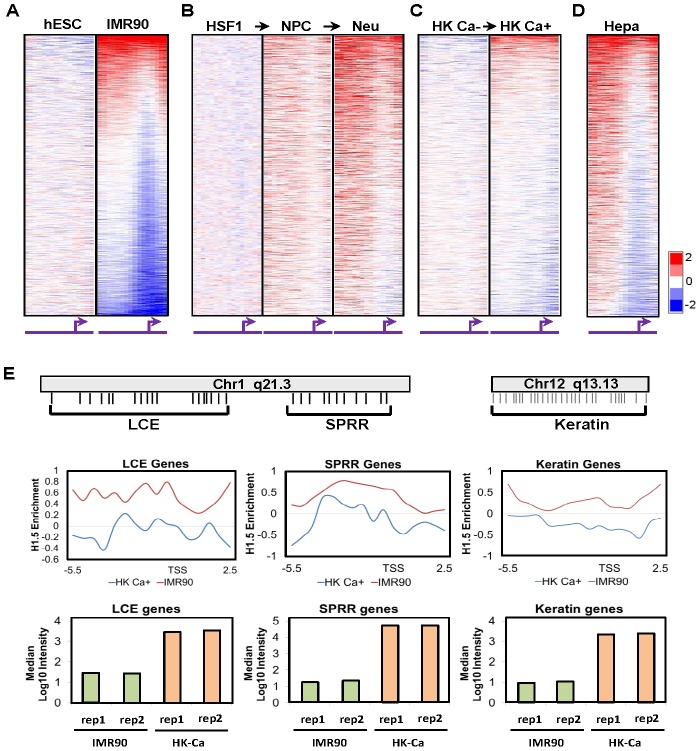
H1.5 distribution is established during cellular differentiation.Heat maps show the genome wide promoter distribution of H1.5 in (A) H1 hESCs and IMR90 fibroblasts, (B) HSF1 hESCs, neural progenitor cells (NPC), neural cells (Neu), and (C) primary keratinocytes (HK Ca−), calcium-treated keratinocytes (HK Ca+), and (D) primary human hepatocytes (Hepa). Each row represents the promoter of a gene in 500-bp intervals from −5.5 to +2.5 kb of the transcription start sites (TSS) which is indicated by the arrows. The gene promoters for all heat maps are ordered based on the highest to lowest level of H1.5 enrichment in fibroblasts. (E) Average H1.5 enrichment and expression of the epidermal (LCE, SPRR) and KRT gene clusters in HK Ca+ and IMR90 fibroblasts are shown as line charts and bar graphs, respectively. The relative position of genes in each cluster is illustrated schematically.